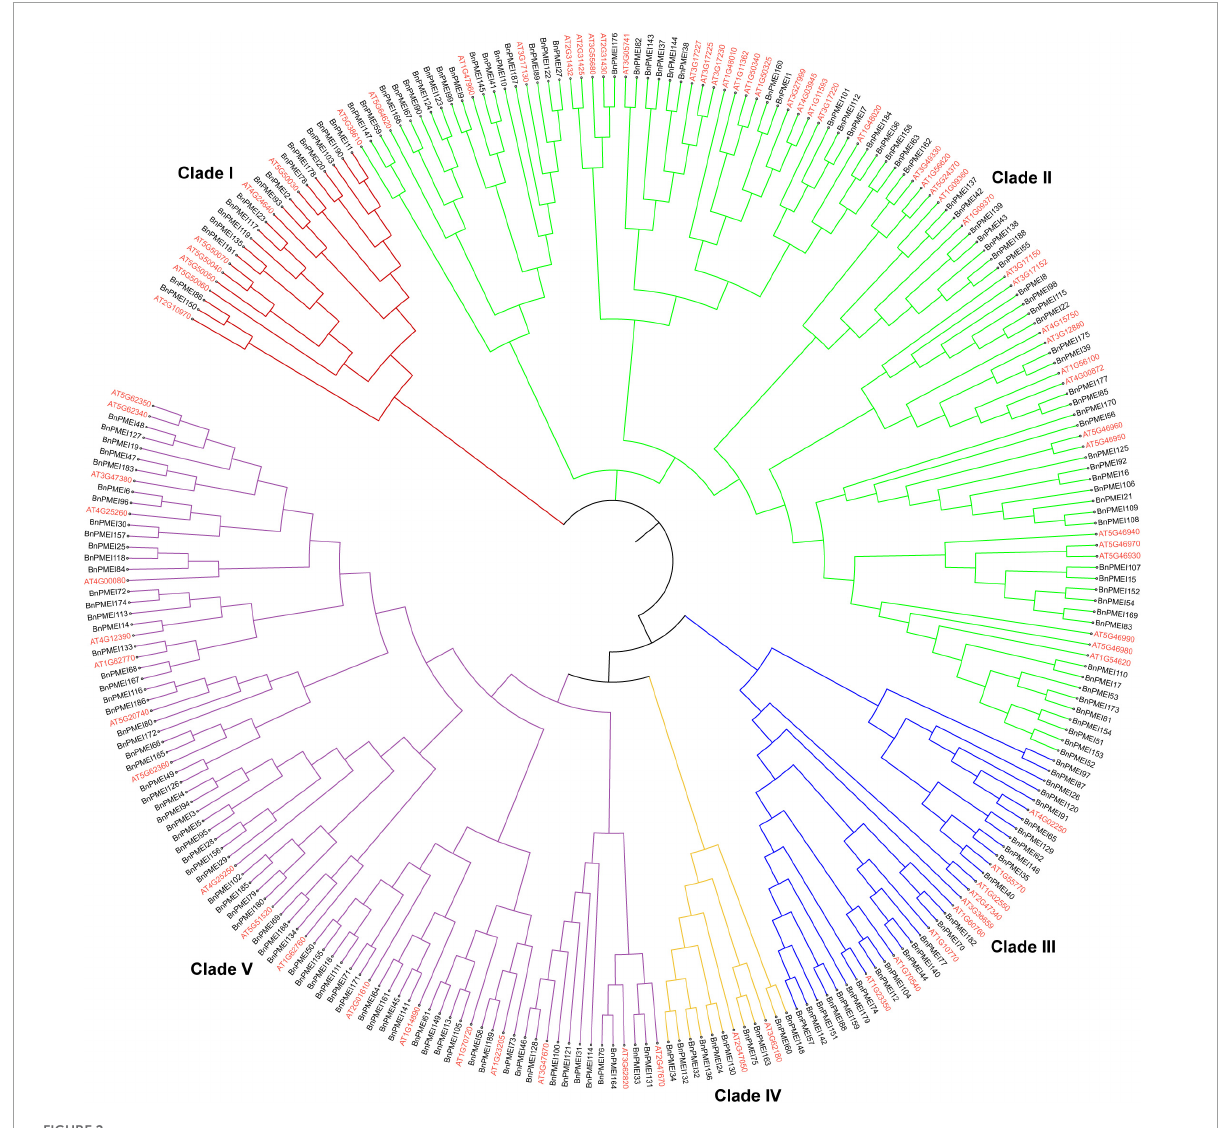
FIGURE2 Phylogenetic analysis of PMEI proteins in B. napus and A. thaliana . The unrooted maximum likelihood (ML) phylogenetic tree was constructed using full-length amino acid sequences of 267 PMEI proteins from both species with MEGA11. Gene IDs in red color represented PMEIs from A. thaliana , and gene names in black indicated PMEIs from B. napus . The arcs in different colors indicated different clades of the PMEI